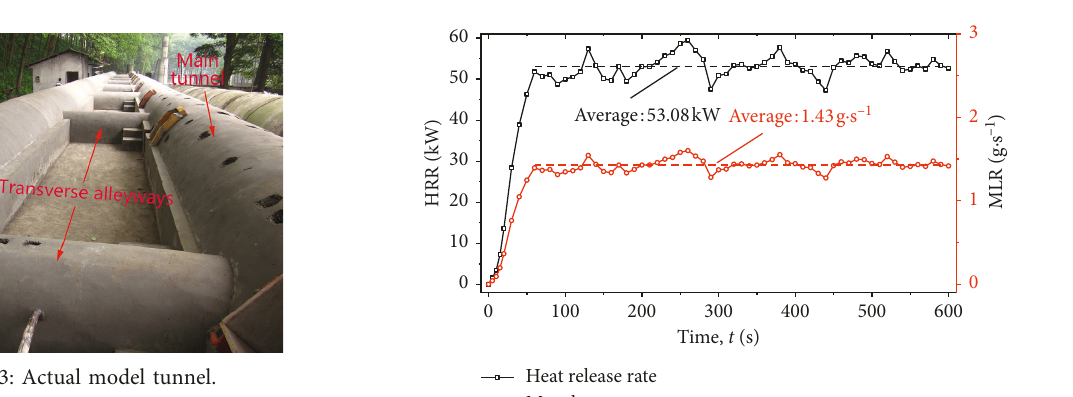
Figure 2: (a) Top view of the fire tunnel experiment with measurement sections. Cross sections of (b) the main tunnel with thermocouples and (c) the cross passage.